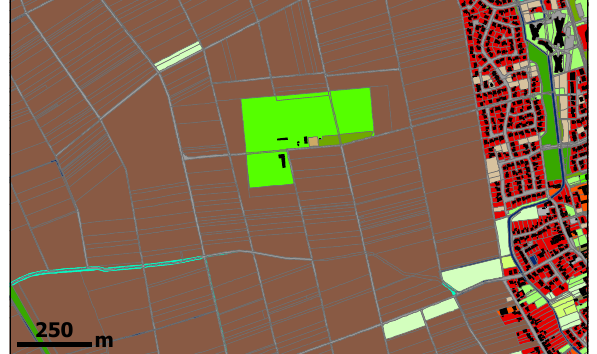
Figure 5. Example of the selected and aggregated ALK classes for the land use analysis (class colours correspond with Figure